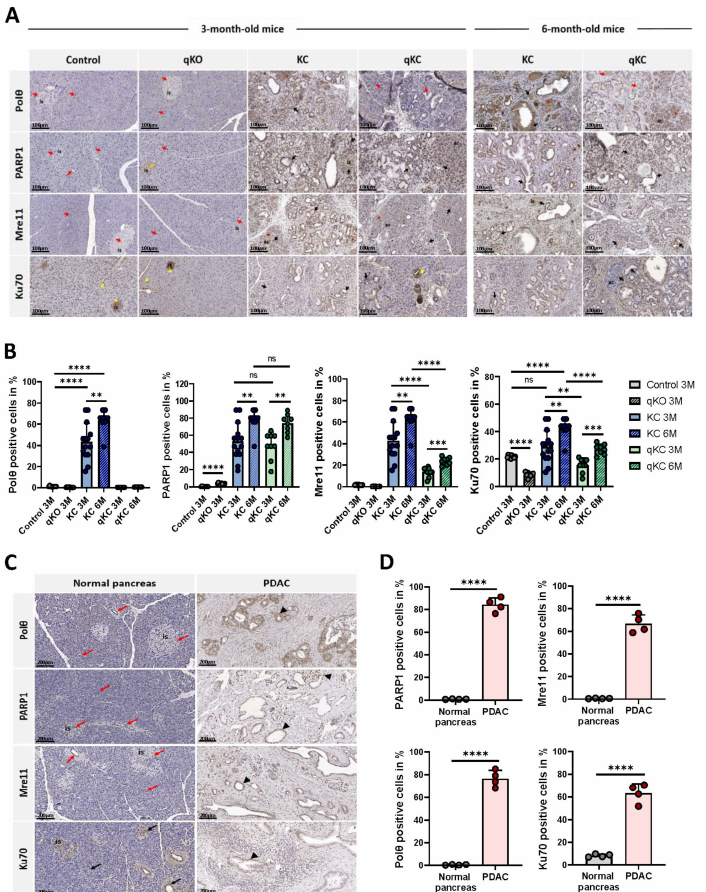
Figure 6. Impact of oncogenic Kras G12D on the expression levels of major alt-EJ and c-NHEJ compo- nents in pancreatic ductal adenocarcinoma. ( A ) Representative immunohistochemical (IHC) staining images for Pol θ , PARP1, Mre11, and Ku70 in the pancreas of control (WT), qKO, KC, and qKC mice at 3 months of age, and 6 month old KC and qKC mice. Nuclear expression of PARP1, Mre11, and Ku70 detected in PanINs, acini (ac) and islets (is) in 3 and 6 month old KC and qKC mice (black arrows). High expression of Ku70 seen in the cytoplasm of low-grade PanINs in 3 month old qKC mice (yellow arrow). Pol θ expression is seen only in 3 and 6 month old KC mice (black arrows). Absence of PARP1 expression in normal ducts, acini, and islets (red arrows), but visible positive staining in islets of qKO mice (orange arrows). Ku70 nuclear and cytoplasmic staining detected in islets and acini of WT and qKO mice (yellow arrowheads). Absence of Pol θ and Mre11 immunoreac- tivity in normal ducts, acini, and islets of WT and qKO mice (red arrows). Non-specific cytoplasmic staining for Pol θ and Mre11 noted in KC and qKC mice (red asterisks). Scale bars represent 100 µ m. ( B ) Histological score of Pol θ -, PARP1-, Mre11-, and Ku70-positive cells in pancreas of experimental mice groups (control mice, n = 10; qKO mice, n = 10; KC mice of age 3 months, n = 14, 6 months, n = 9; qKC mice of age 3 months, n = 9, 6 months, n = 8). Error bars represent mean ± SD; * p < 0.05, ** p < 0.01, *** p = 0.0001, **** p < 0.0001; ns = not significant (Student’s t -test). ( C ) Representative immunohistochemical images for Pol θ , PARP1, Mre11, and Ku70 in normal human pancreas and PDAC. Absence of Pol θ , PARP1, and Mre11 immunoreactivity in normal ducts, acini, and islets (is) (red arrows). Positive immunohistochemical staining of Ku70 noted in normal ducts, acini, and islets (black arrows). High nuclear expression of Pol θ , PARP1, Mre11, and Ku70 detected in PDAC (black arrowheads). Scale bars represent 200 µ m. ( D ) Histological score of Pol θ , PARP1, Mre11, and Ku70 positive cells in normal pancreas (n = 4) and PDAC (n = 4). Error bars represent mean ± SD; **** p < 0.0001 (Student’s t